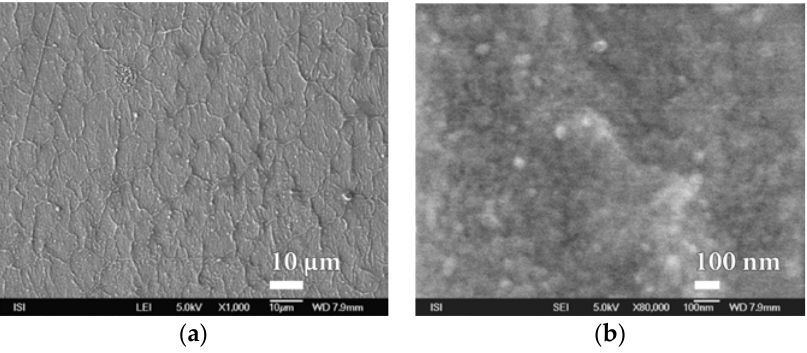
Figure 10. SEM micrographs of the surface SiO x barrier nanocoating prepared by plasma deposition with the PVD method on PVDC foil laminated on the PEVA foil, at magnification of ( a ) 1000× and ( b ) 80,000×.